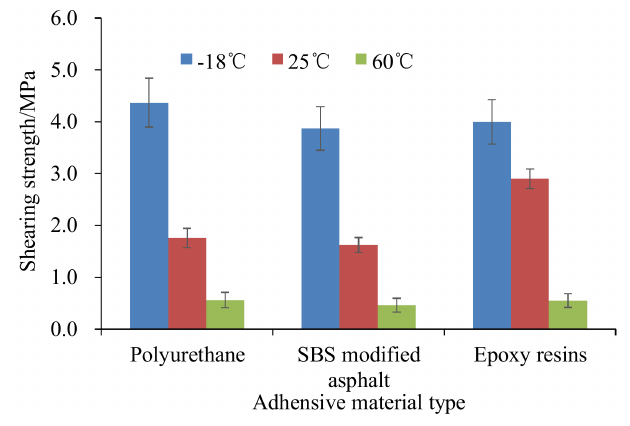
Figure 8. Shear strengths of PPM-10 + AC-20 composite specimen with 0.5 mm adhesive layer at different temperatures.